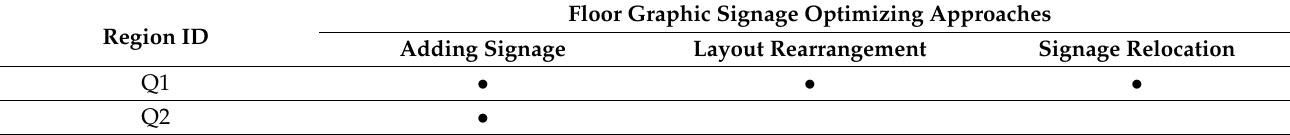
Table 25. Approaches for optimizing floor graphic